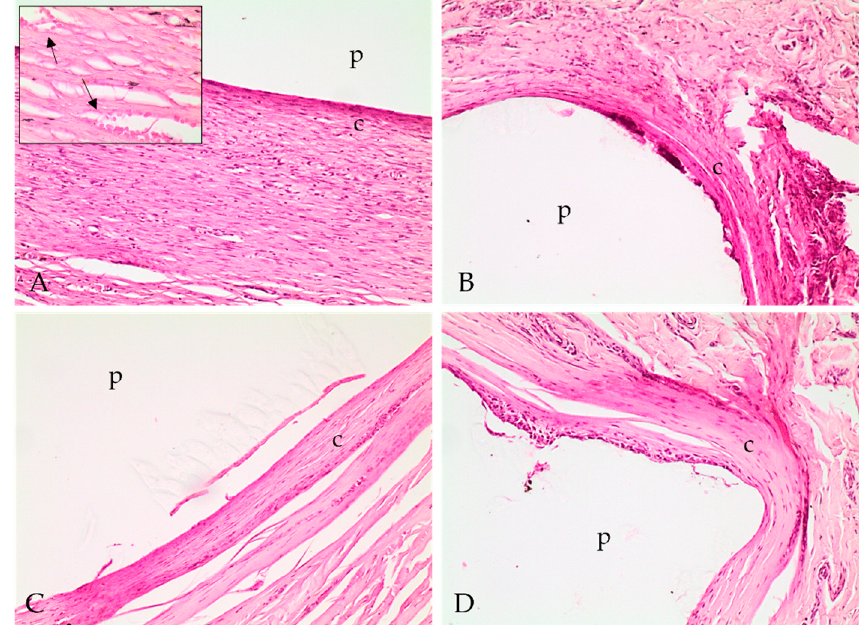
Figure 2. Photomicrographs of implant polymer sites with the polymer (p) and fibrotic capsular formation (c) involving the material. ( A ) Fibrotic capsular formation at 24 weeks; ( B ) 28 weeks; ( C ) 34 weeks; and ( D ) 38 weeks. Hematoxylin and eosin stain, 100×. (A) Inlet: fibrotic capsular formation at 24 weeks with small vases proliferation (arrows), characterizing angioplasia. Hematoxylin and eosin stain, 400×.